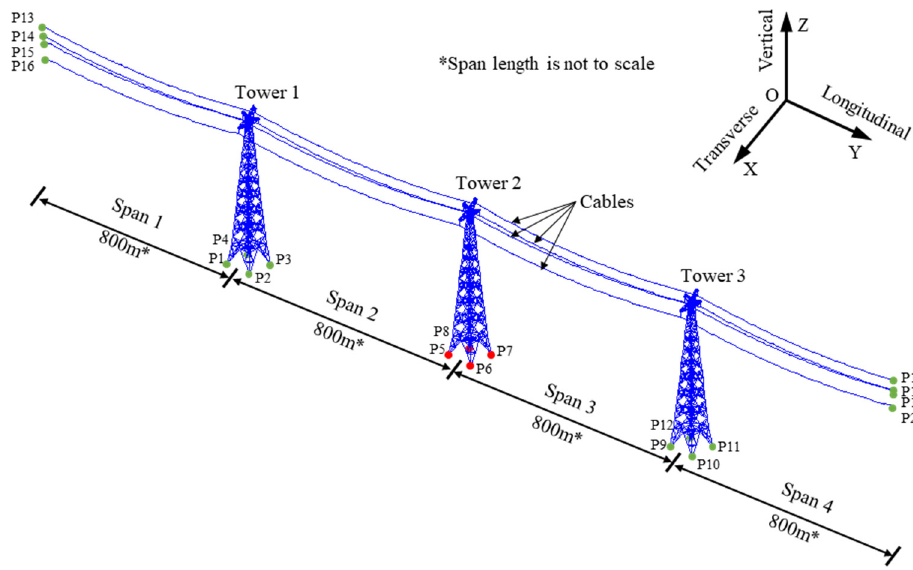
Figure 8. Numerical model of the structure.